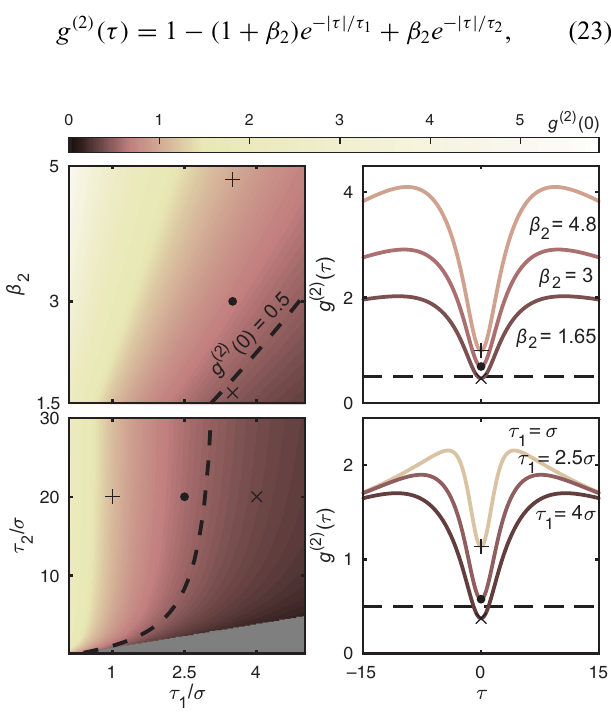
FIG. 4. The effect of timing jitter on g ( 2 ) ( 0 ) . Left: the value of g ( 2 ) ( 0 ) is calculated as a function of the ratio of τ 1 /σ and /σ or β τ 2 2 for a three-level system with time scales and bunching amplitude β 2 and a Gaussian IRF with standard deviation σ . Right: six points are selected from the parameter combinations on the left to illustrate how g ( 2 ) (τ) at low delays changes for different ratios of τ 1 /σ (bottom) and different values of β 2